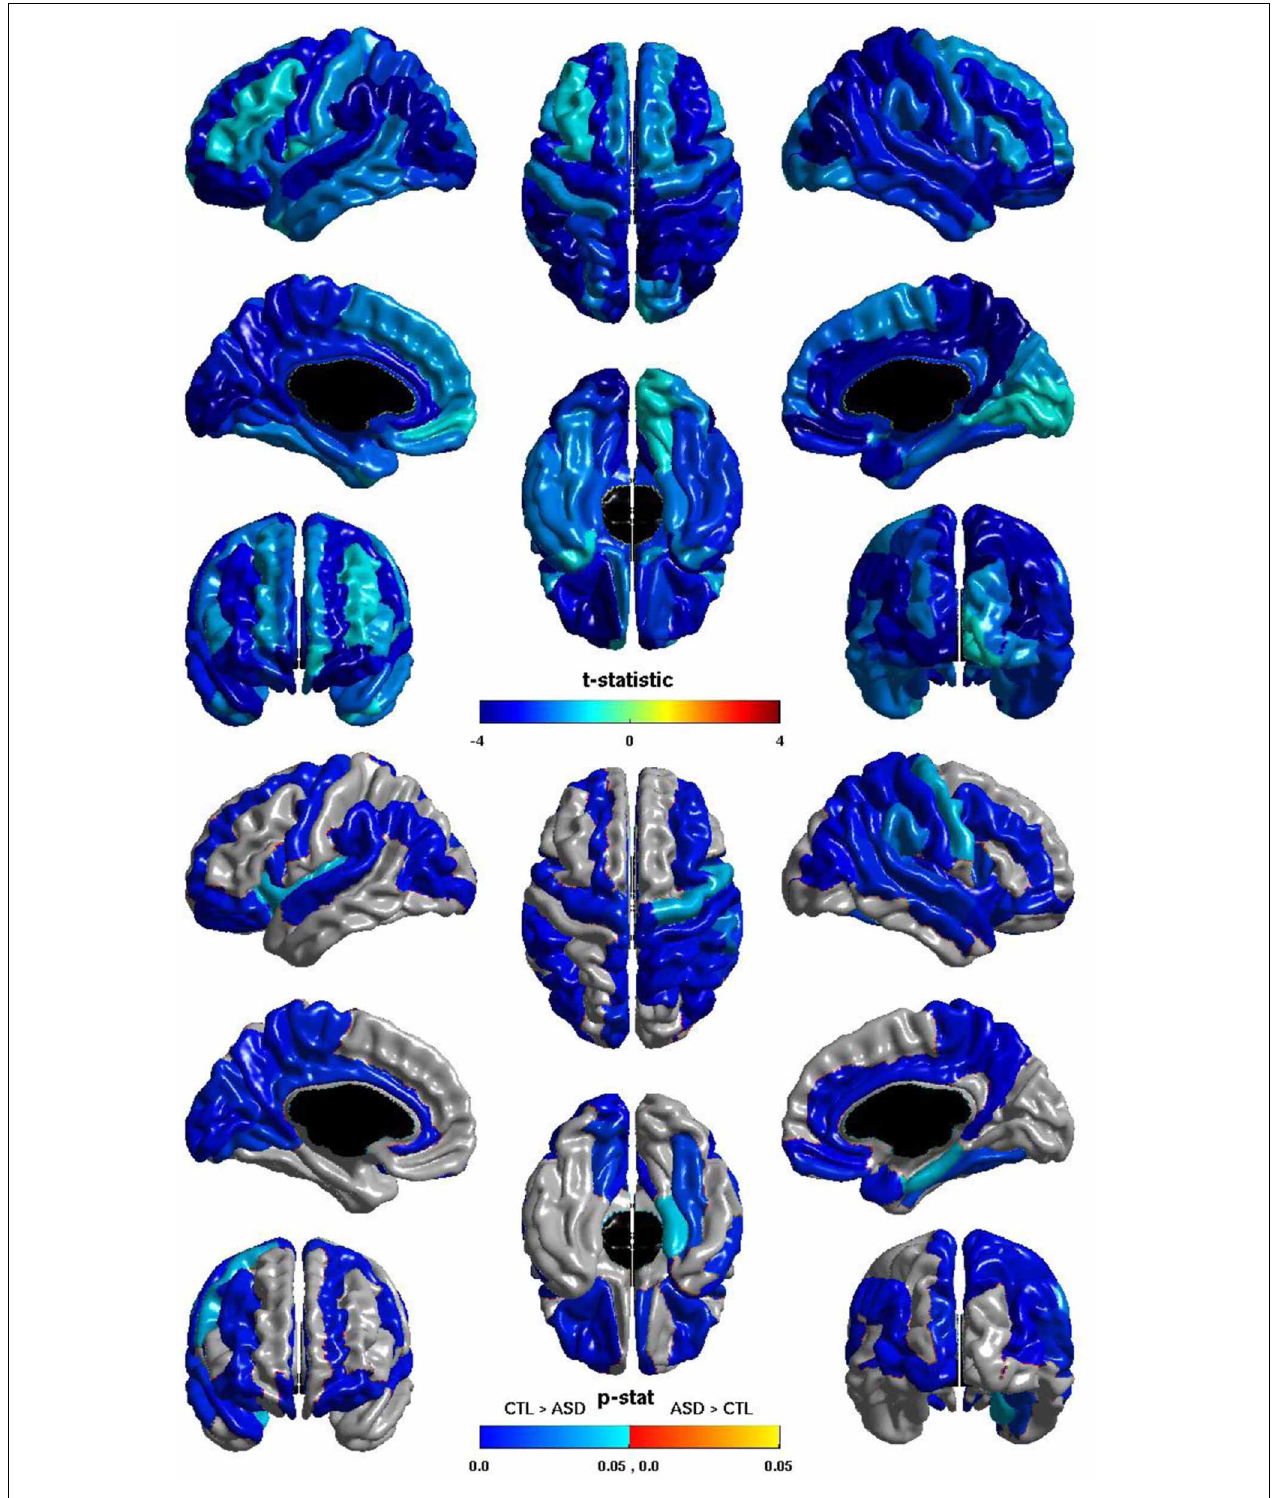
FIGURE 5 | Nodal Global Efficiency and Group. The t -statistic (top) and the p -statistic (bottom) for the group difference in nodal global efficiency in each region of the AAL atlas. A negative t -statistic represents reduced efficiency in ASD. The t -statistic is negative everywhere. The p -statistic is FDR-corrected, and is blue where